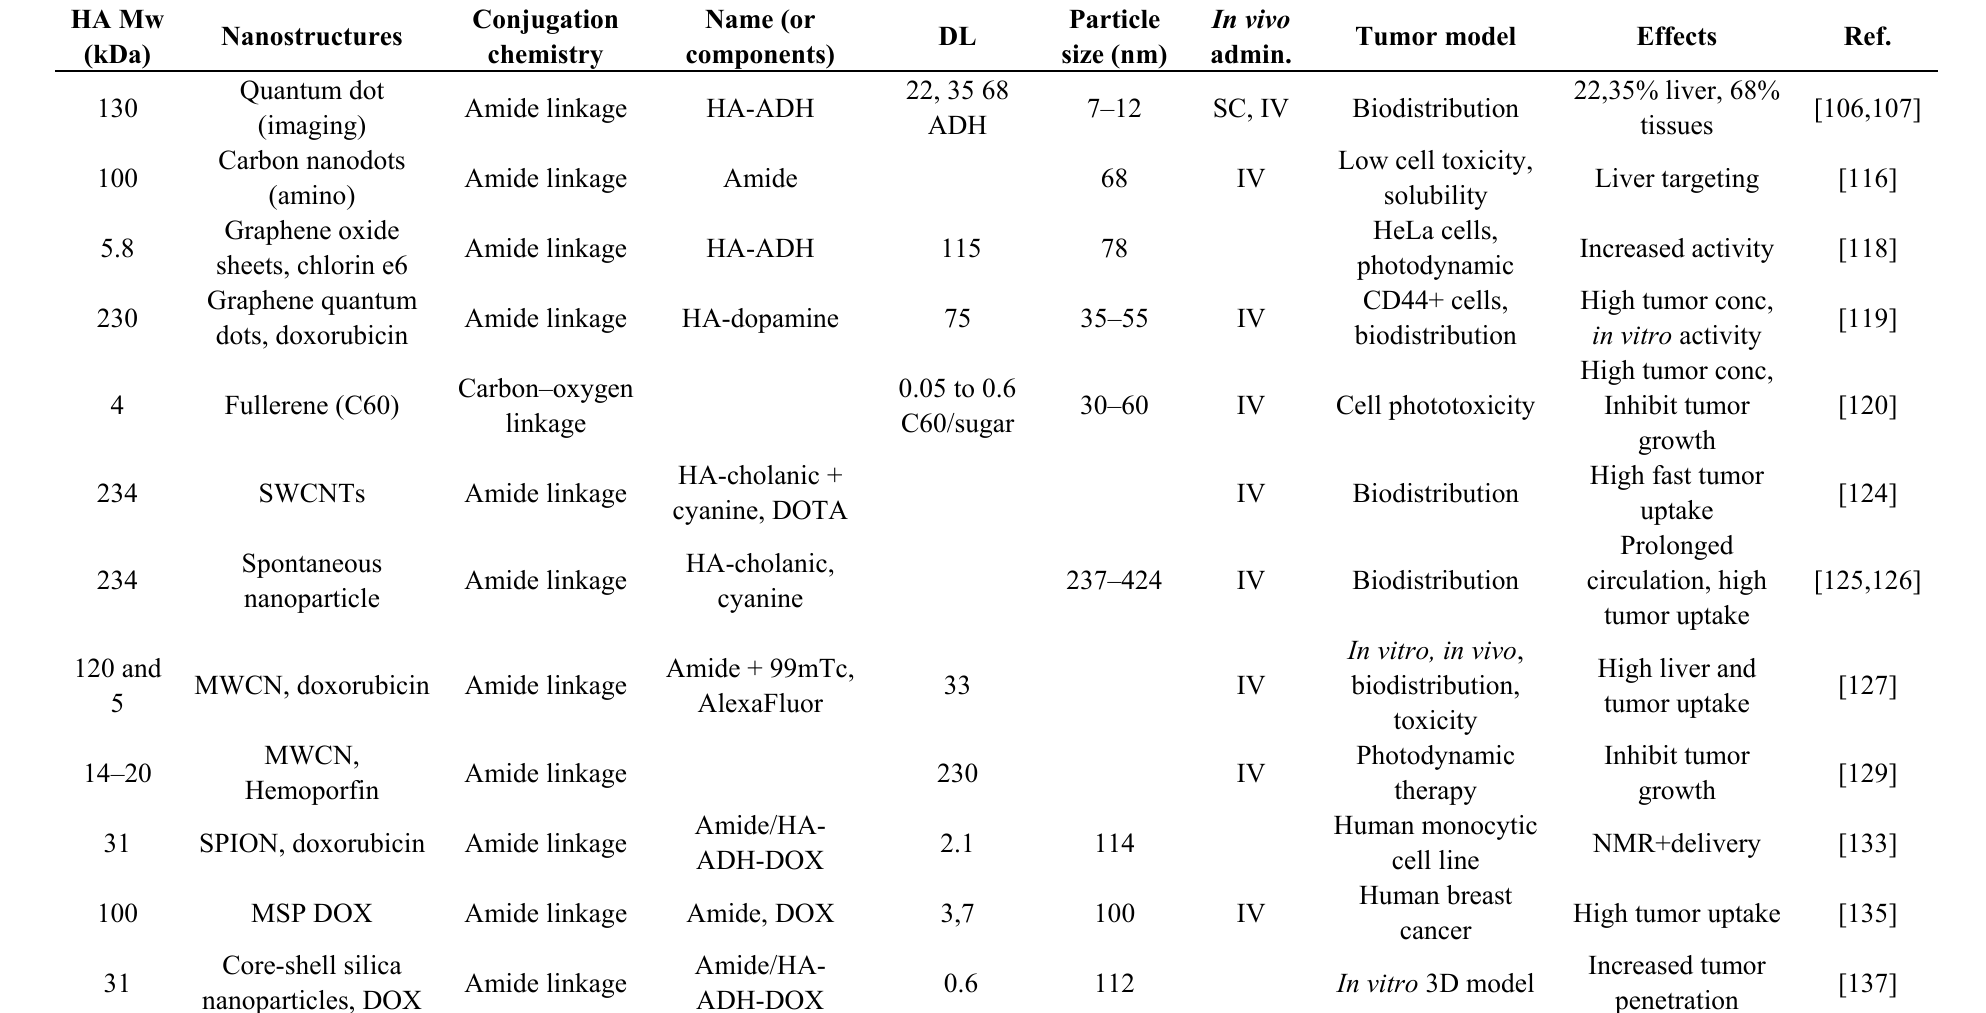
Table 4. Summary of the characteristics of HA-nanostructures